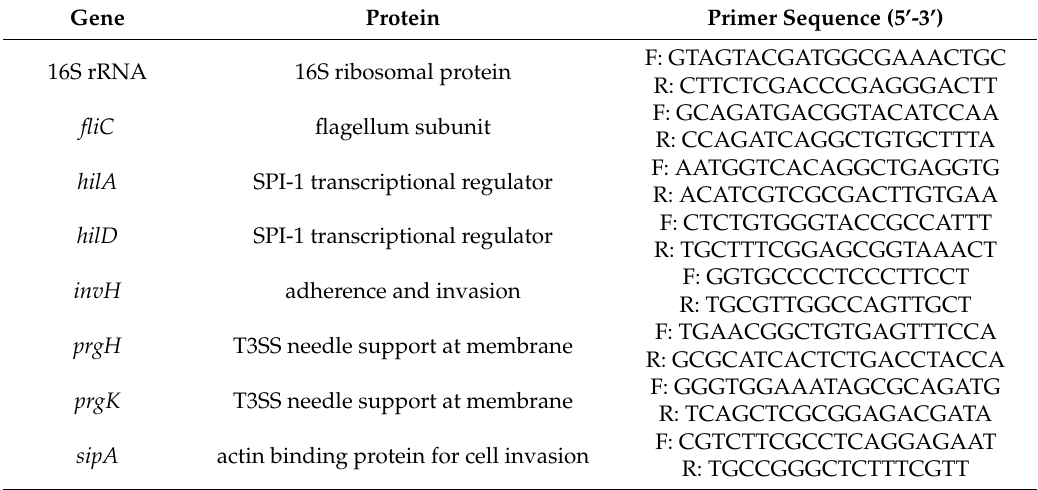
Table 2. Primers used in determining gene expression of ST